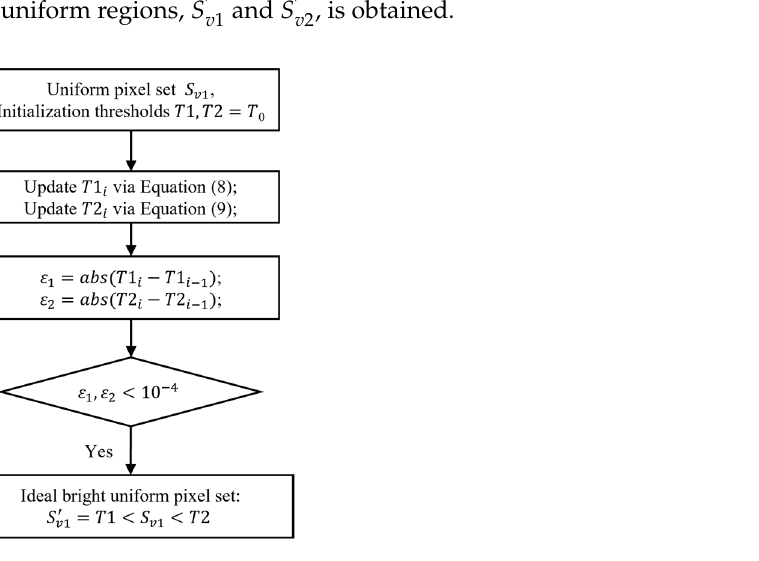
Figure 7. Flow chart detailing how to obtain the ideal bright uniform region.